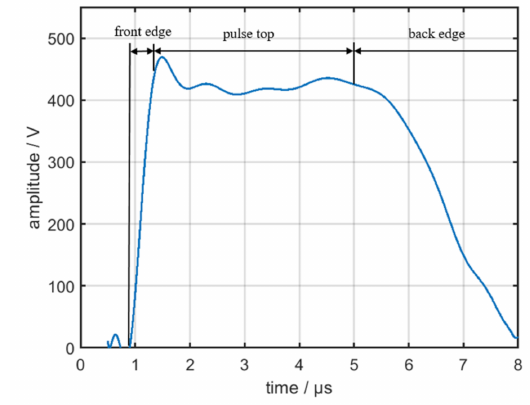
Figure 12. Real waveform of the modulated signal.